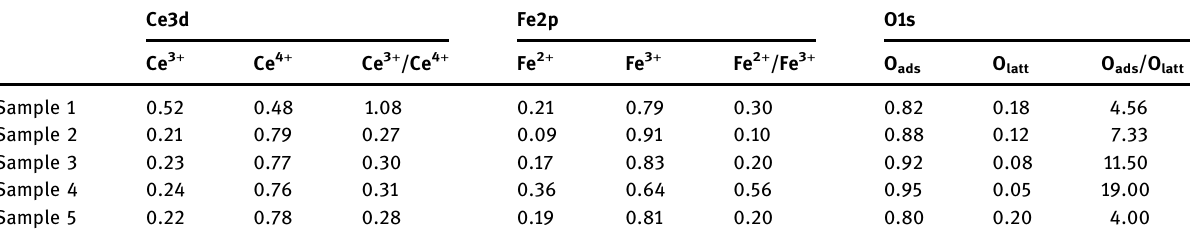
Table 5: Surface compositions and oxidation states of the samples. Ce3d